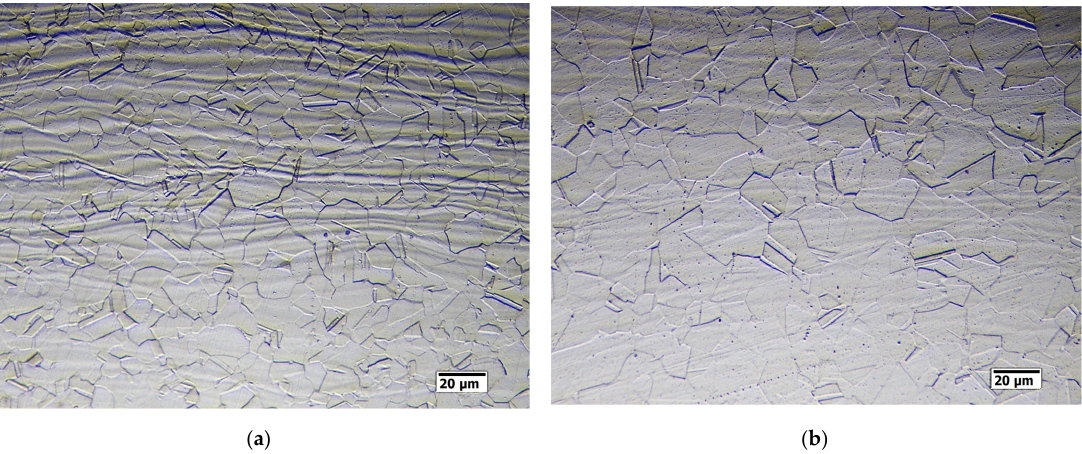
Figure 9. AISI 904L steel after cold rolling at 70% and annealing at ( a ) 1050 °C for 40 s and ( b ) 1150 °C for 20 s.